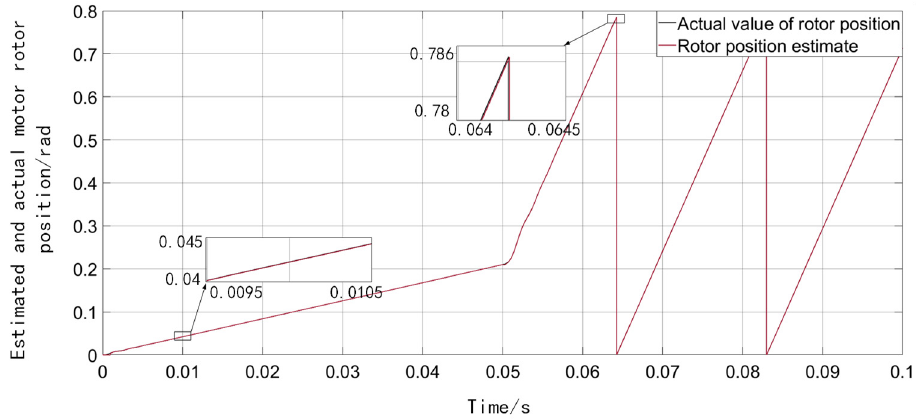
Figure 12. Comparison chart of the motor rotor position of the new and improved SMO at low